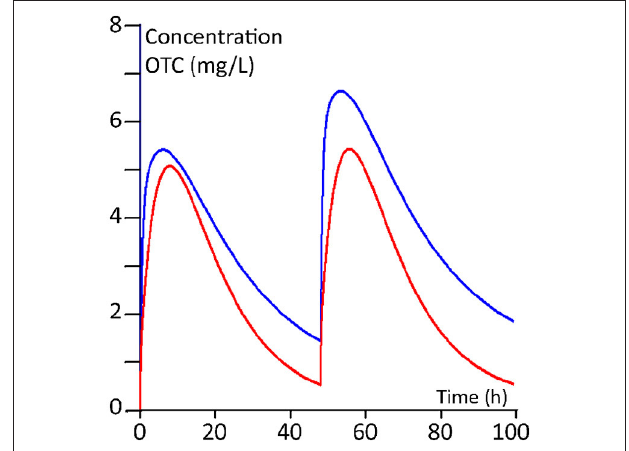
FIGURE 6 | Twenty mg/kg regimen (twice with an interval of 2 days). Red line: 100kg BW calves; blue line 400kg BW calves. TABLE 7 | Median AUCs at days 1, 2, 3 and 4 for the daily 10 mg/kg regimen and the twice 20 mg/kg regimen, for both 100 and 400kg BW steer calves.